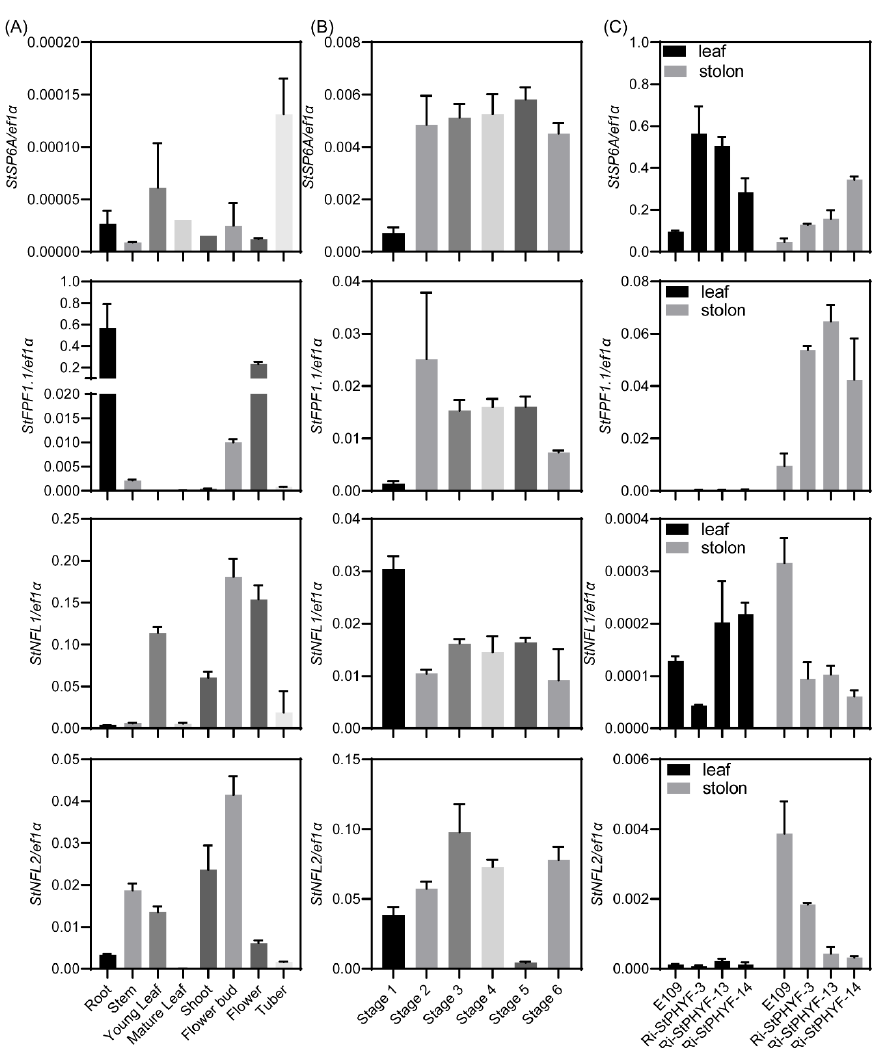
Figure 4. Expression of StAP6A and StSP6A interactors in E109 and StPHYF -interference plants grown in vitro. ( A ) Relative expression of StSP6A and its interactors in different tissues of E109. ( B ) Expression of StSP6A and its interactors in stolons of different stages as defined by Begum et al. [20]. ( C ) Expression of StSP6A and its interactors in leaves and stolons of StPHYF -interference plants with tuberization under non-inductive conditions.